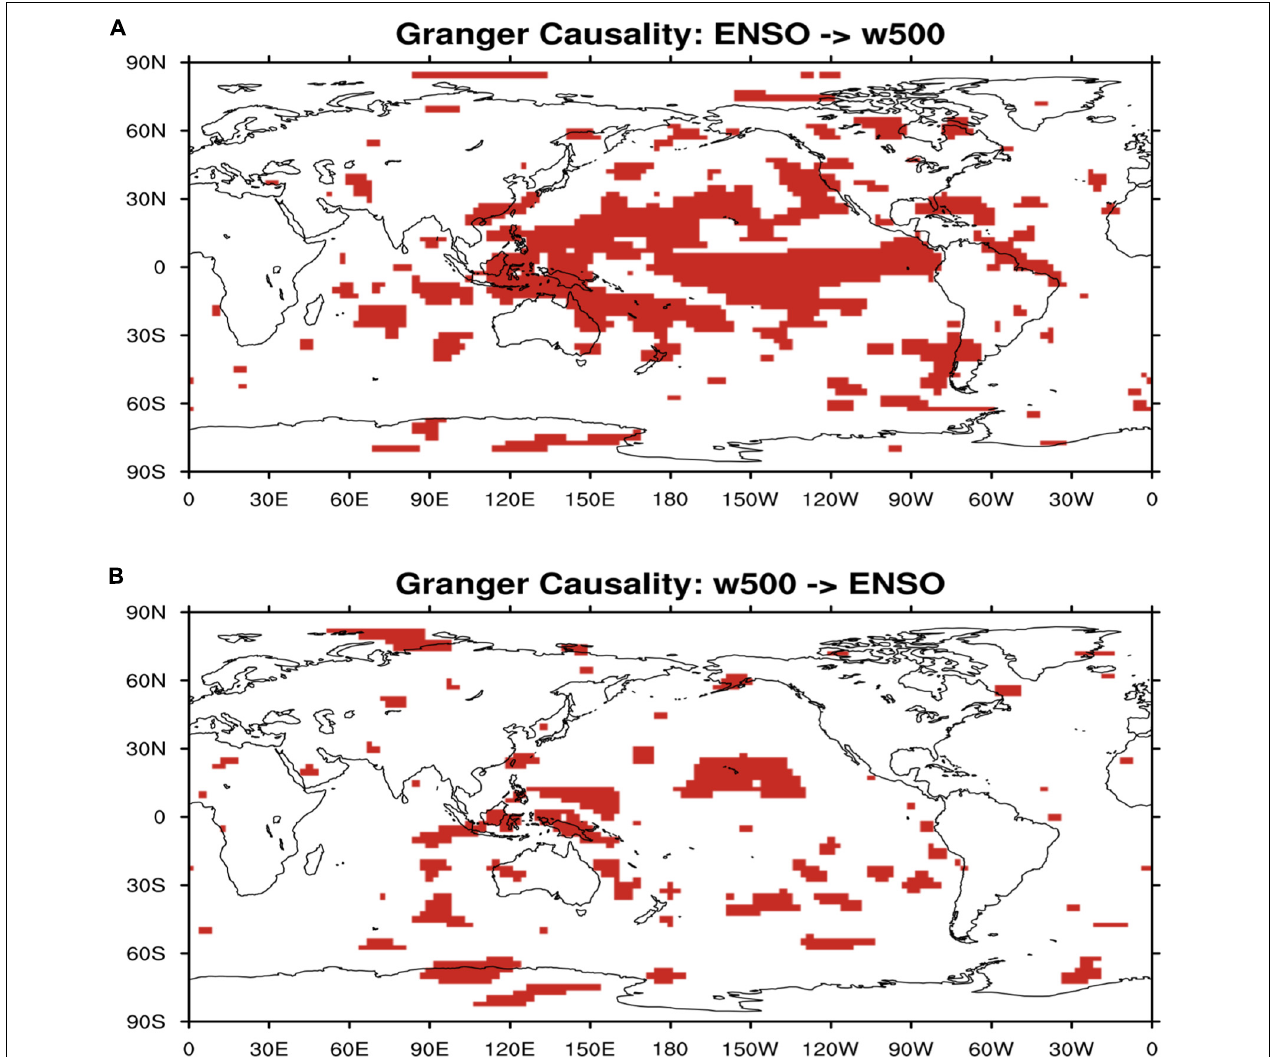
FIGURE 12 | (A) Regions where 500 hPa vertical velocity is granger caused by ENSO index (red shaded). (B) Regions where 500 hPa vertical velocity causes ENSO (red